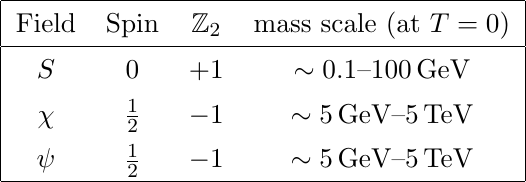
Table 1 . The new particles we introduce in section 2 with their respective charges and mass scales. All new particles are SM gauge